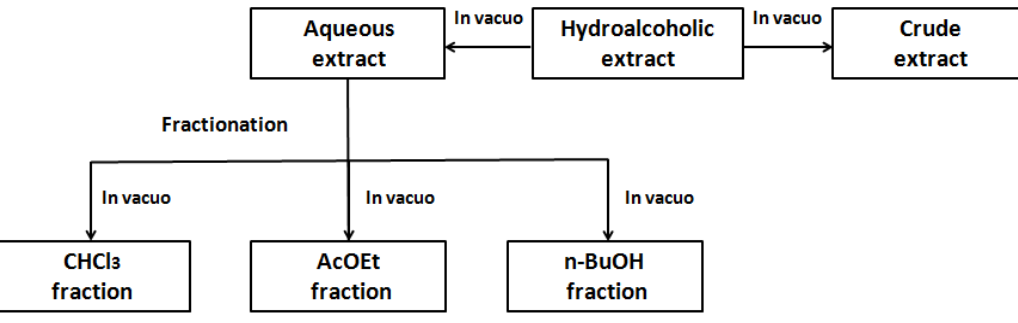
Figure 6. Method of fractionation of S. guaraniticum